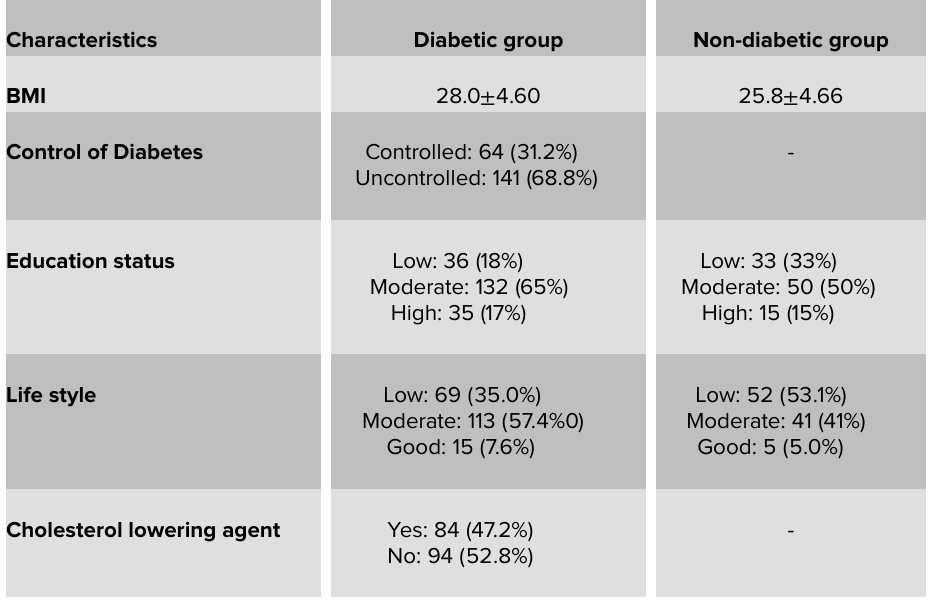
Table 1: General baseline characteristics of patients and control groups.